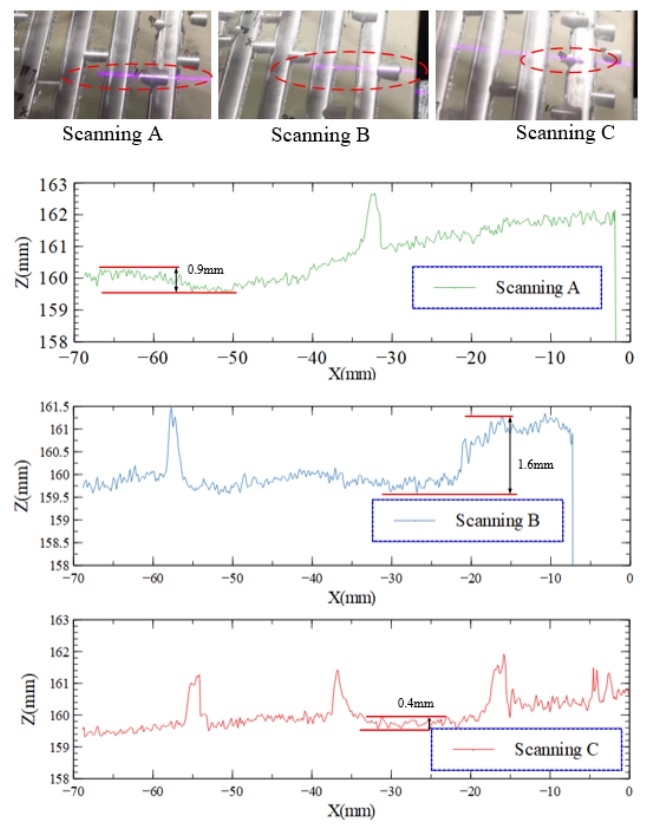
Figure 10. Scanning Result of Weld seam after grinding.